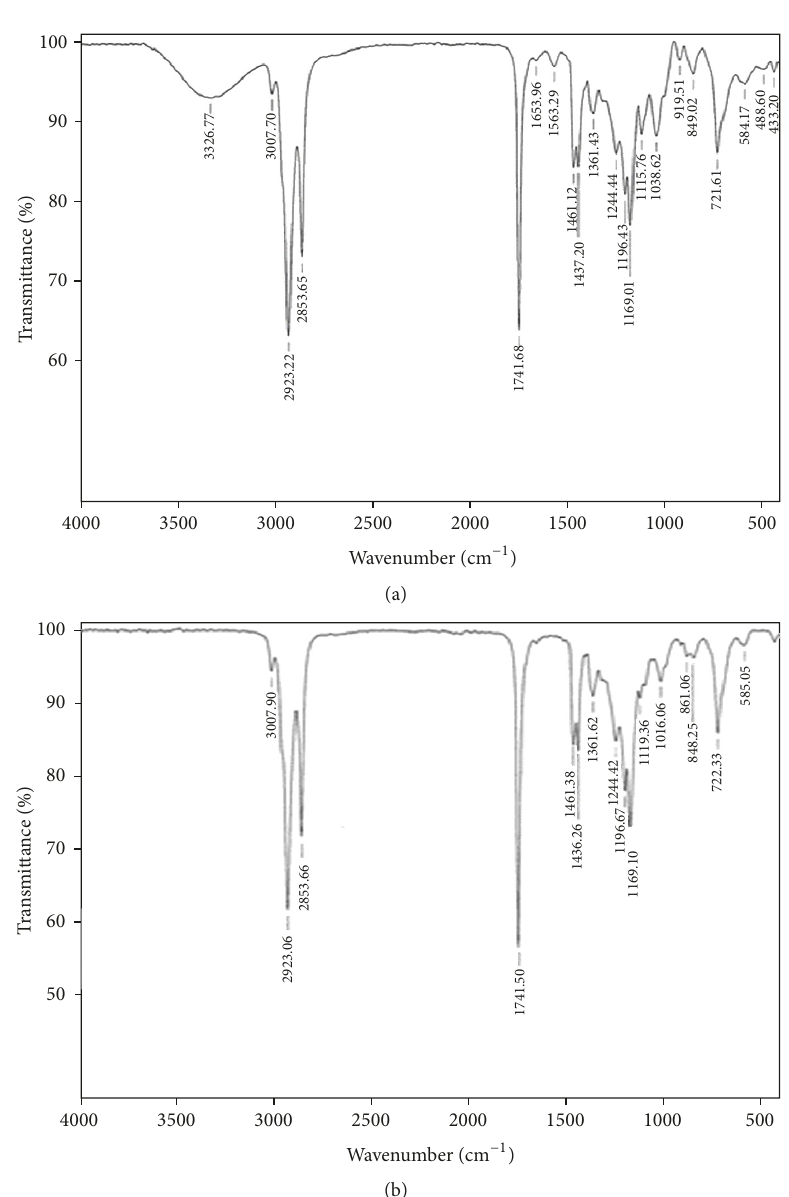
Figure 3: FTIR spectra of the transesterification process: (a) 𝑡 = 20min and (b) purified biodiesel after 120 min of